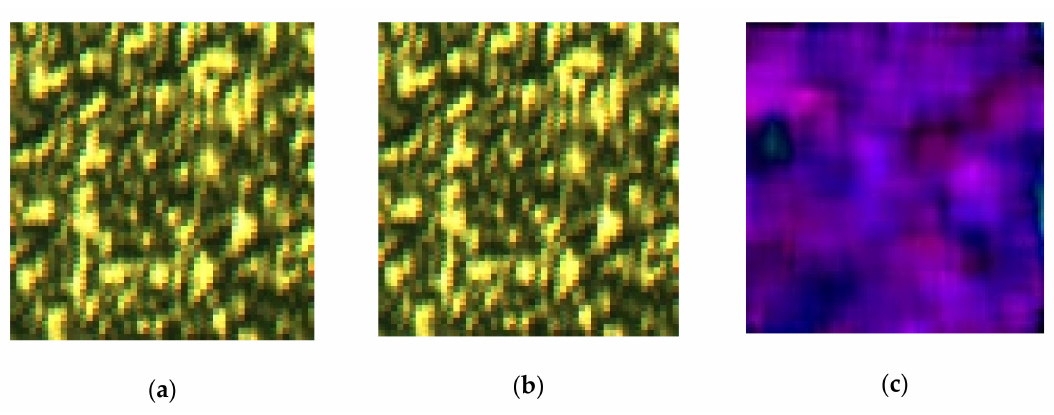
Figure 1. A group of adjacent speckle images (100 × 96 pixels) obtained by Viaxl and an optical flow diagram. ( a ) First frame; ( b ) second frame; ( c ) displacement between two adjacent frames ( a , b ), which was calculated by the acceleration calculation algorithm we